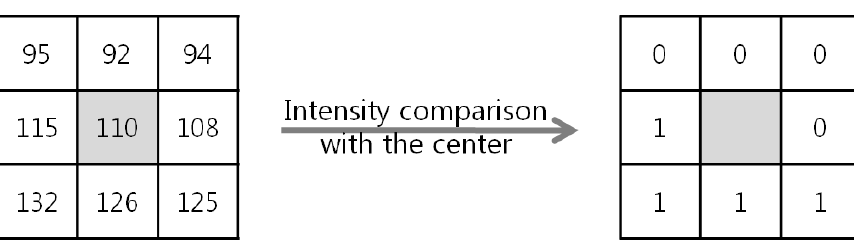
Figure 7. Example of an LBP